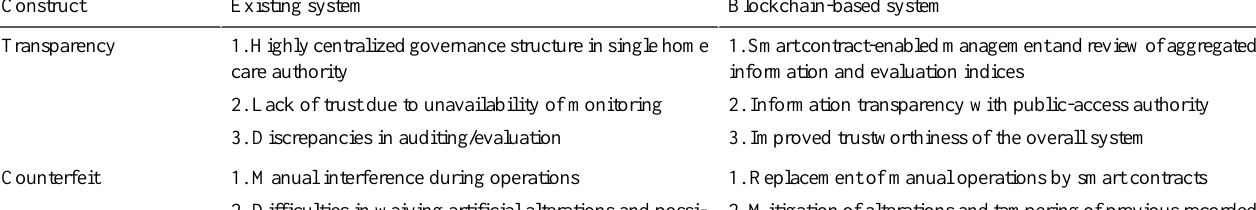
Blockchain-based systemExisting